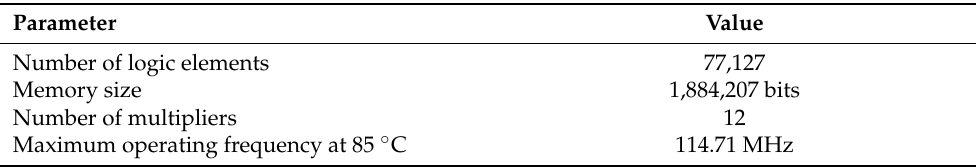
Table 9. FPGA synthesis results of presented digital image decoder.